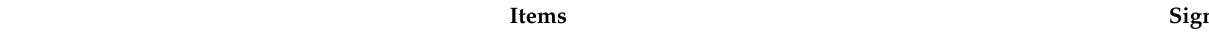
Table 3. Pre- and Post-test .